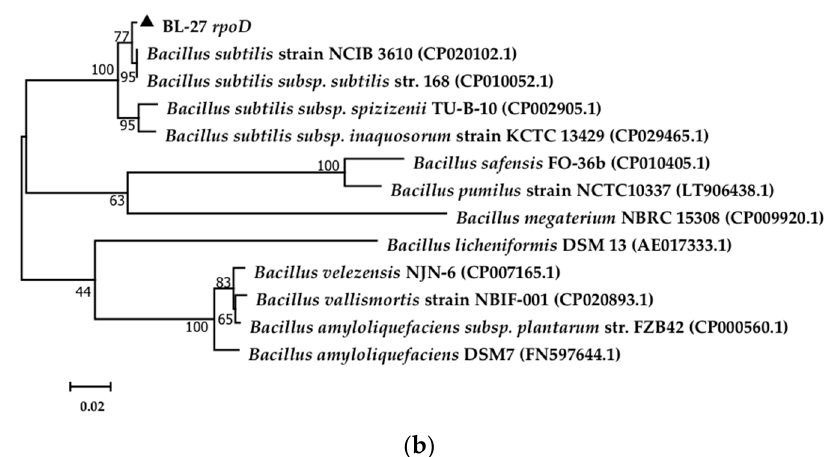
Figure 1. Phylogenetic trees of the strain BL-27 with closely related sequences from the GenBank database; constructed based on the 16S rDNA and rpoD gene sequences using the Maximum Likelihood method and GTR model. GenBank accession numbers are shown in parentheses. ( a ) Phylogenetic tree of the strain BL-27 based on 16S rDNA gene sequences; ( b ) Phylogenetic tree of the strain BL-27 based on the rpoD gene sequences.